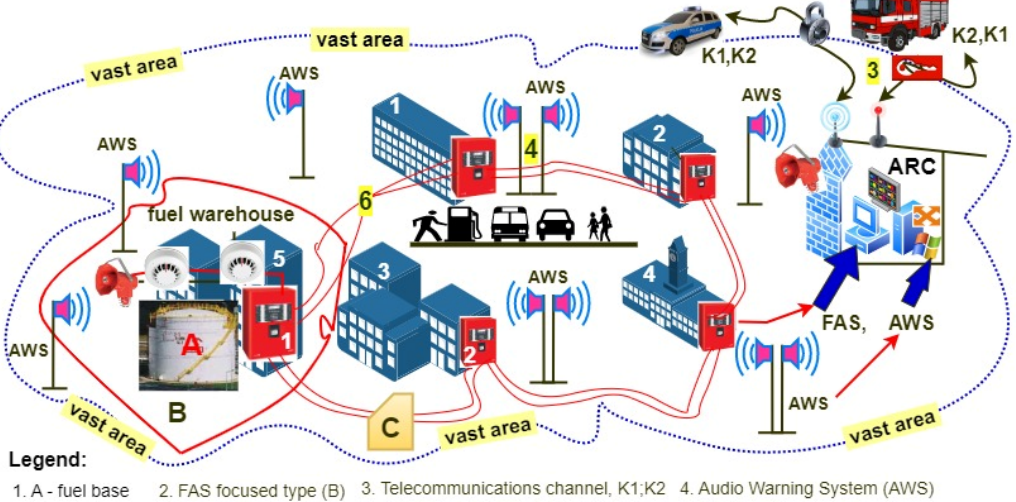
Figure 2. IESS operated in a vast critical infrastructure area, including a fuel base monitored by a concentrated FAS and a distributed AWS. Individual FACUs (1, 2, . . . , 5) connected by double telecommunication lines (fibre optic cable) in a ring. Designations used in the figure are explained in the figure key.